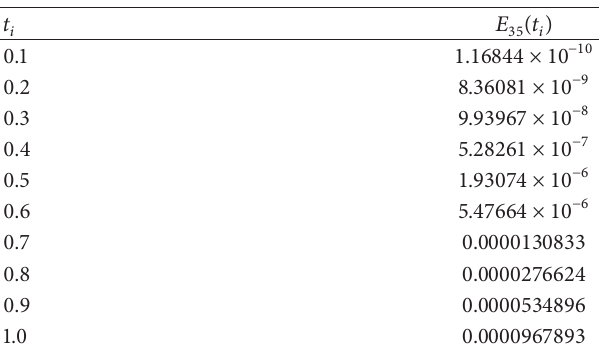
Table 1: The error of Example 4 for 𝑁 = 35 and different values of 𝑡 .